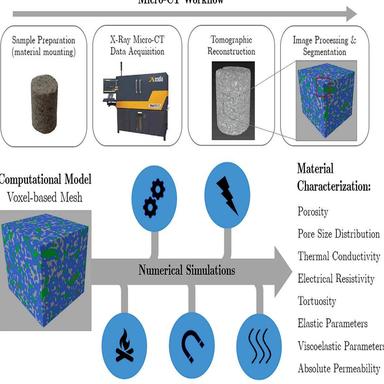
Workflow for material characterization in a Digital Laboratory.